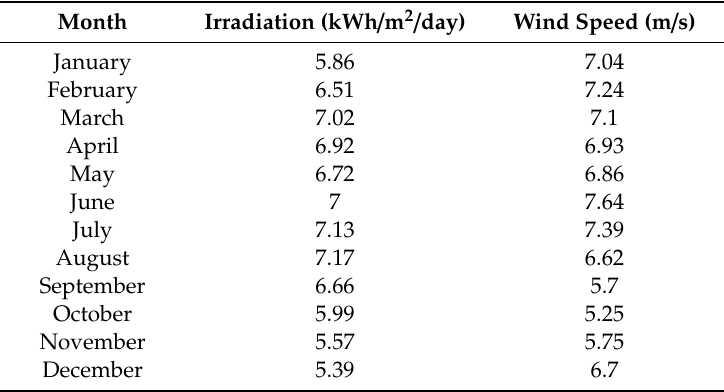
Table 1. Irradiation and wind speed at the microgrid location.